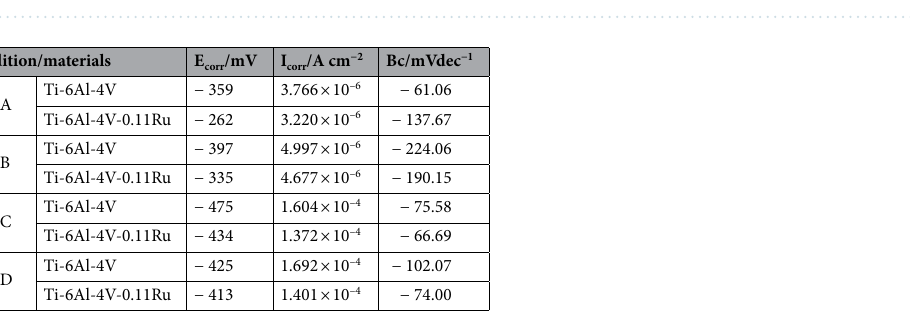
Figure 2. Potentiodynamic polarization curves for the tested titanium alloy samples under various test conditions: ( a ) Ti-6Al-4V and ( b ) Ti-6Al-4V-0.11Ru.